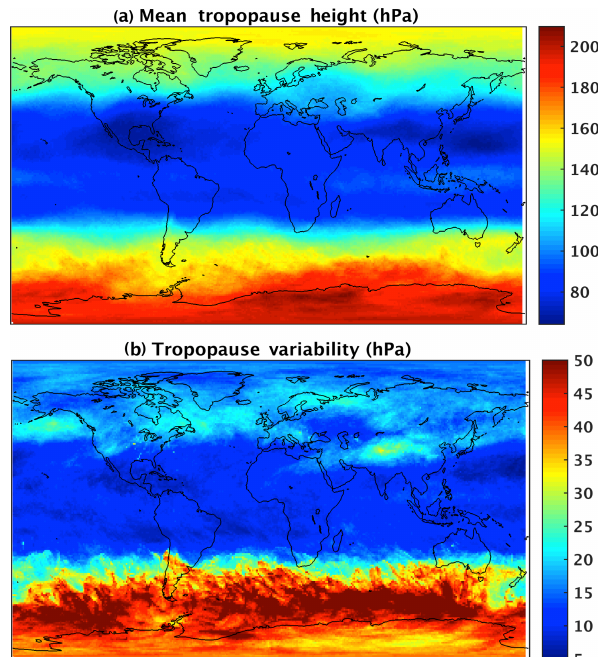
Figure 3. (a) Mean tropopause height (in hPa) and (b) variability (standard deviation) of tropopause height (in hPa) from the C-IFS model fields for June–August